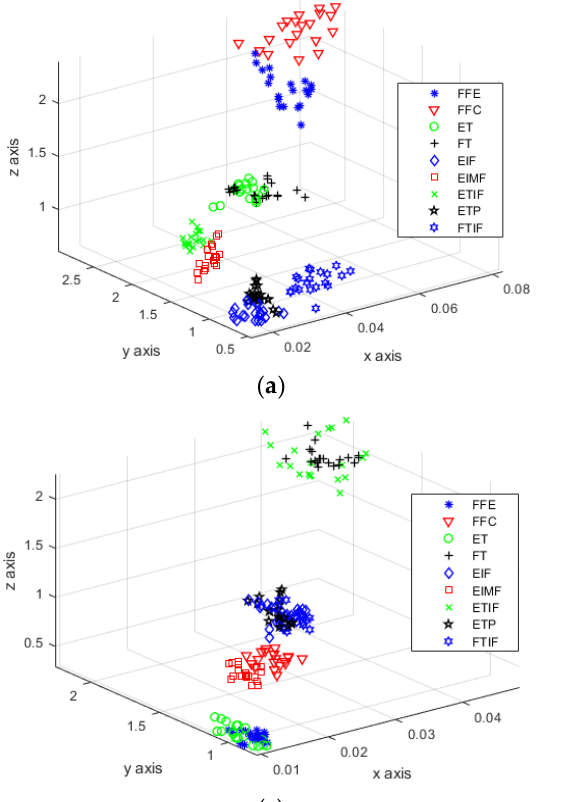
Figure 10. Multiscale singular value decomposition (SVD) analysis. ( a ) Maximum singular value of sub matric division along time axis; ( b ) Maximum singular value of sub matric division along frequency axis; ( c ) SVD of global matrix.